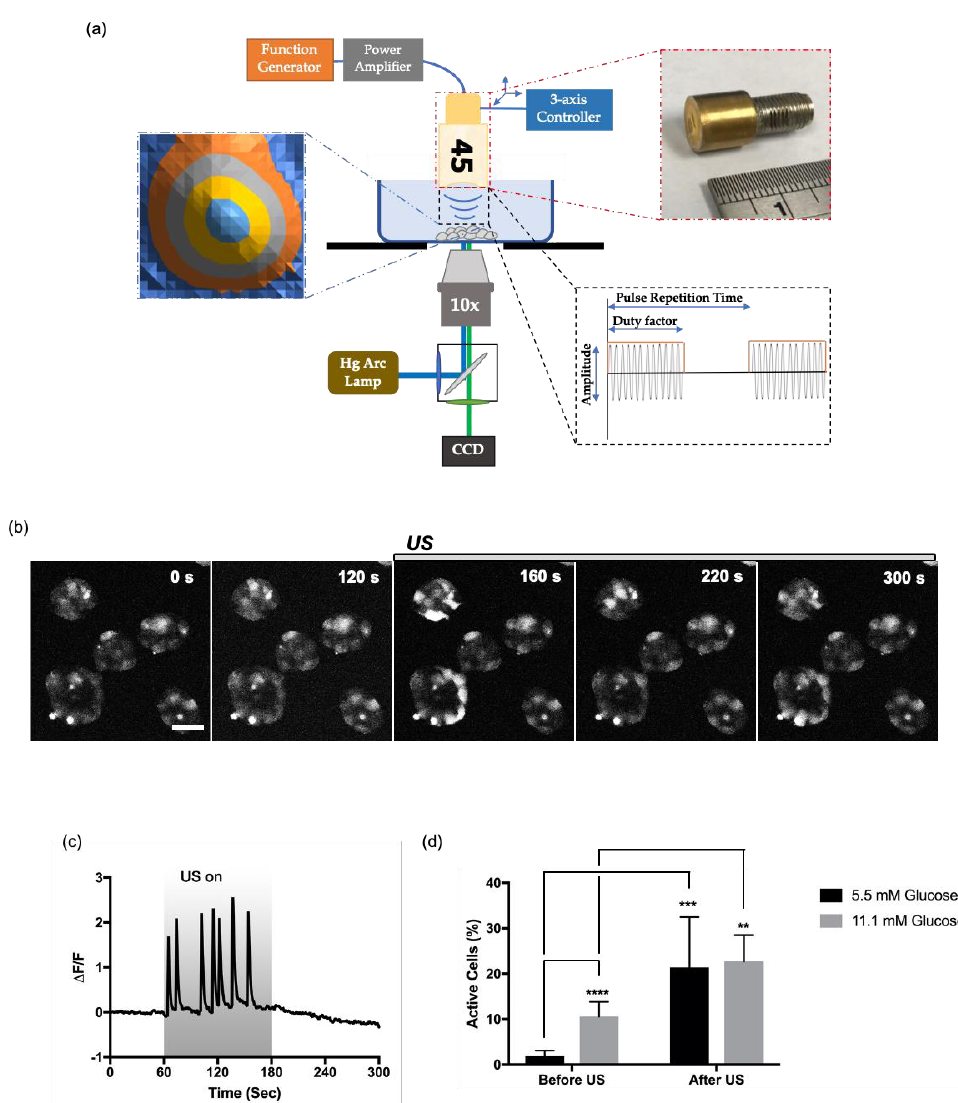
Figure 1. Ultrasound-induced intracellular Ca 2 + dynamics in HIT-T15 pancreatic β -cells. ( a ) Schematic diagram of an ultrasound stimulation system. A pulsed sine wave was generated by a function generator and amplified by a power amplifier to drive a 45-MHz focused transducer. The position of the transducer was controlled by a three-axis stage controller. The focal distance from the transducer to the surface of culture dish was aligned using a pulser–receiver. Ultrasound-induced intracellular Ca 2+ dynamics were monitored by an inverted epifluorescence microscope. ( b ) Time lapse images of HIT-T15 cells before and after ultrasound stimulation. Scale bar 50 µm. ( c ) Ultrasound-induced Ca 2+ oscillation from a single HIT-T15 cell. The cells were bathed in HBSS+ with 11.1 mM glucose. The gray box indicates the duration of ultrasound exposure. ( d ) Percentage of cells active in Ca 2+ signaling before and after ultrasound stimulation. The cells were adapted to different glucose concentrations, 5.5 mM and 11.1 mM, for 1 h before the imaging. The error bar indicates S.D. **, ***, and **** indicate p -value less than 0.01, 0.001, and 0.0001, respectively.